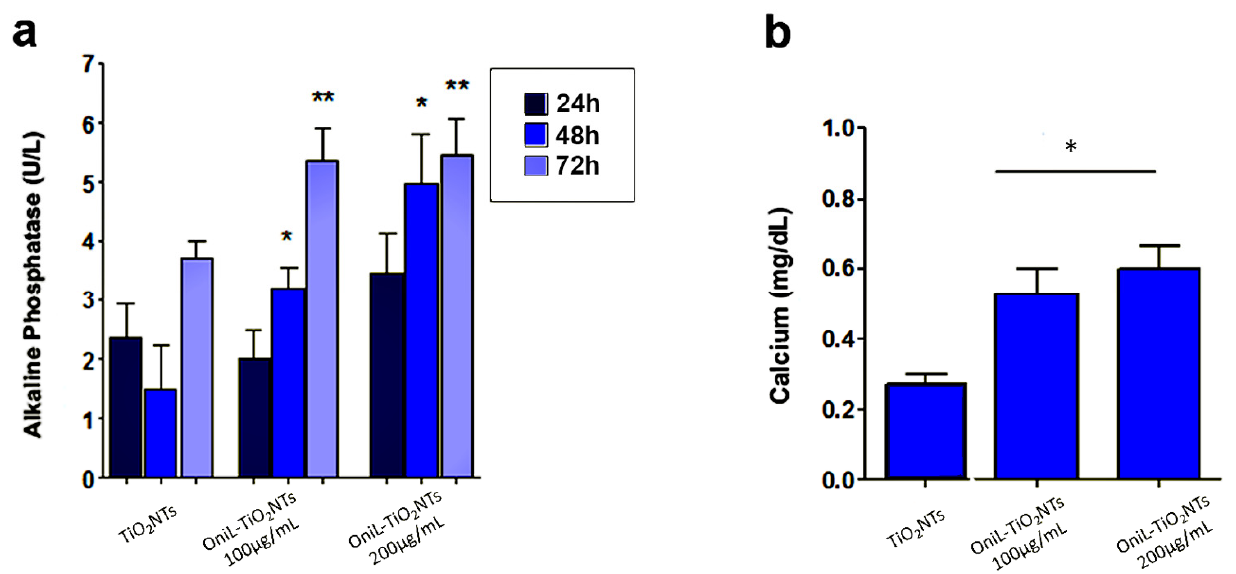
Figure 5. Osteogenic activity of osteosarcoma cells adhered to TiO 2 -modified surfaces ( a ) ALP activity ( b ) calcium quantification, after 72 h of cultivation. The data were obtained from two independent experiments in triplicate. Significant differences compared TiO 2 NTs, p < 0.05 for (*) 24 h and (**) 48 h of incubation.